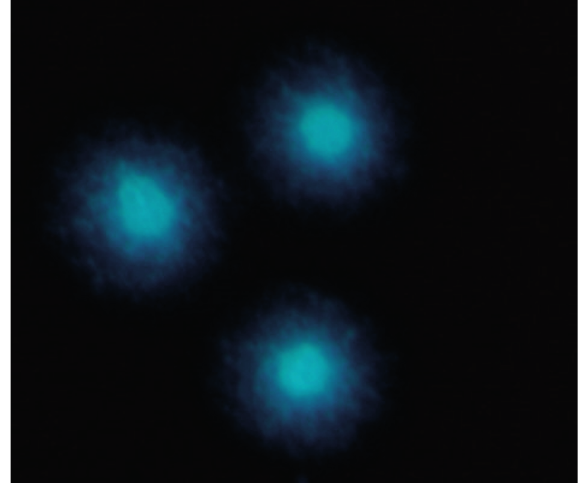
Figure 2. Representative images of DNA comets, obtained from human thyrocytes. The thyrocytes were stained with 4 ′ ,6-diamidino-2-phenylindole (DAPI), observed in fluorescent microscopy at magnification 400×. DNA damage was calculated as the DNA tail area/whole DNA area (%) and the comet tail length (from the center of DNA head to the end of the DNA tail). The picture shows intact cells without the DNA